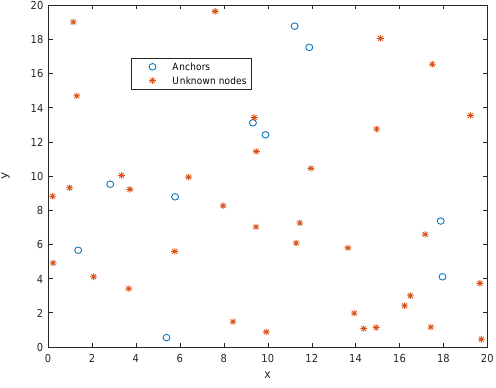
Figure 4. Configuration of the wireless sensor